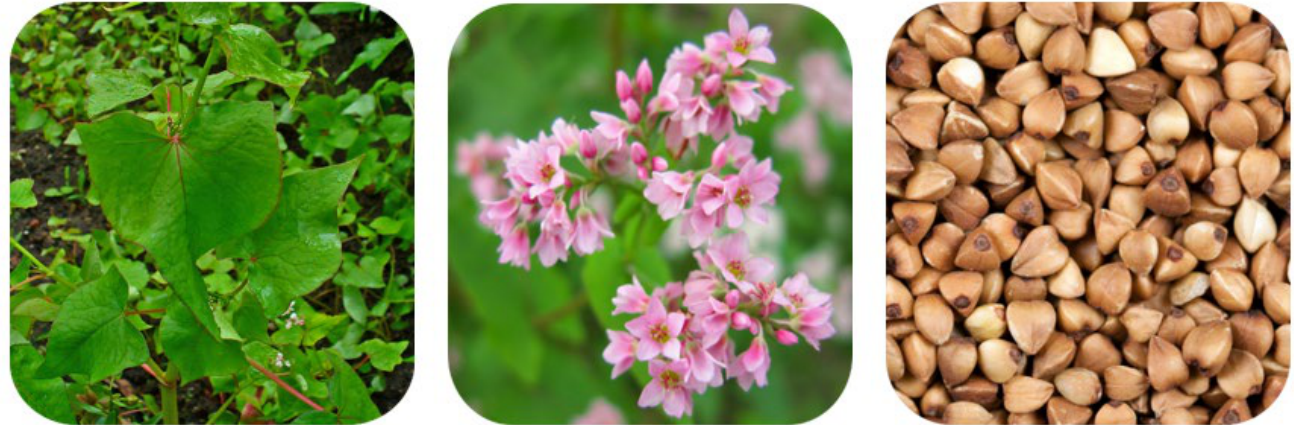
Figure 2. Plant, flowers, and seeds of